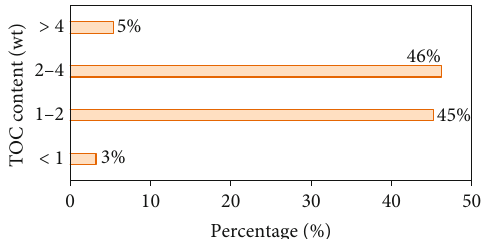
Figure 5: The distribution of the TOC content in the Es4u shale in the Dongying